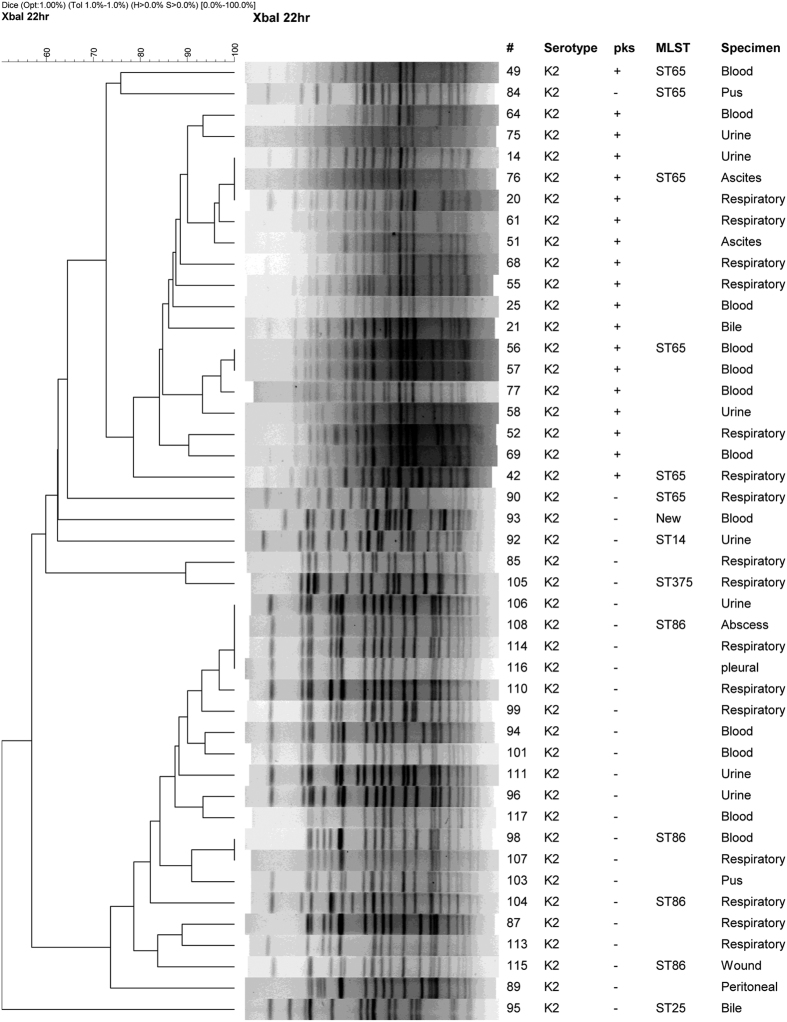
Dendrogram of pks-positive and pks-negative K2 capsular type Klebsiella pneumoniae clinical isolates.Sequence type (ST) 65 and ST86 differ by 5 out of the 7 alleles in the MLST (multilocus sequence typing) profile. The STs of the remaining pks-negative isolates are also distinct from ST65 and ST86. The new ST is a single locus variant of ST110.